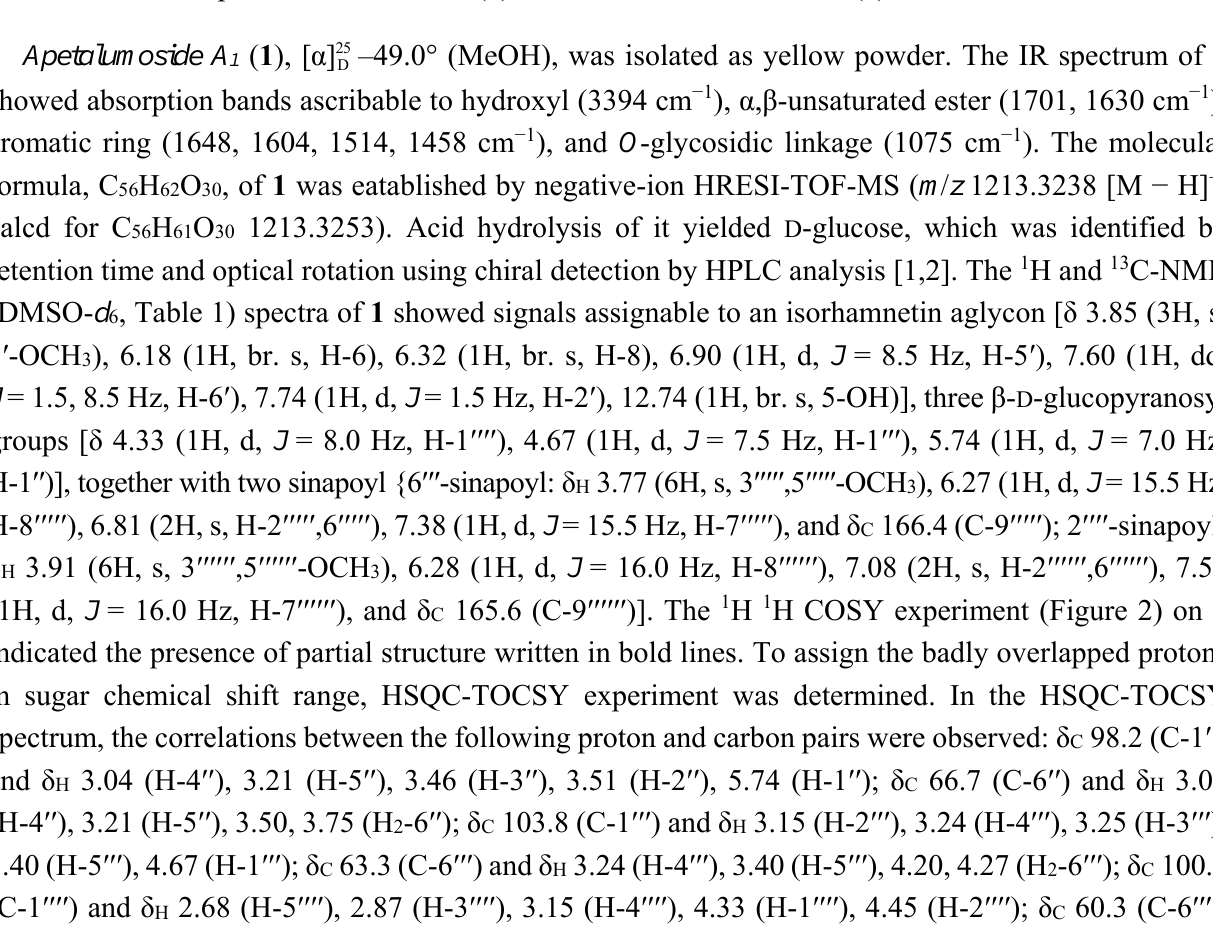
Figure 1. The structure of compounds 1 – 7 . ( A ), the moiety structure which indicated in